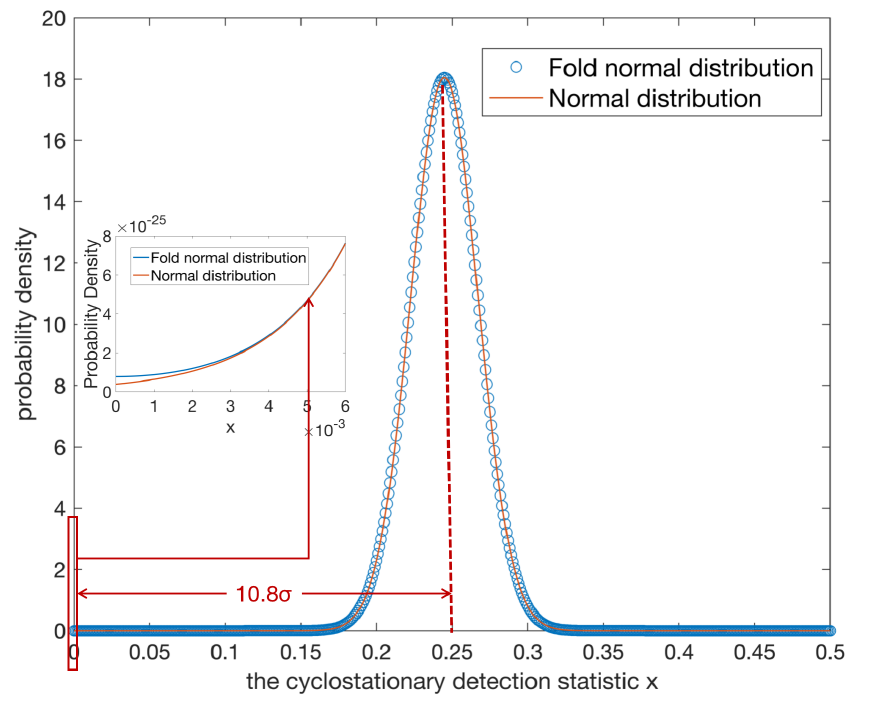
Figure 5. Approximation of folded